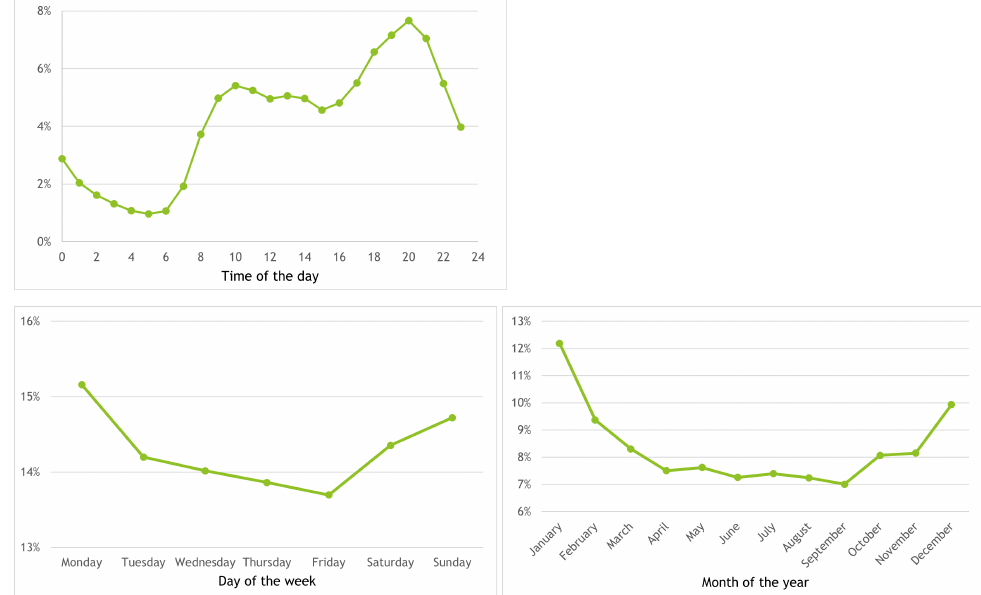
Figure 6. Distribution of calls per hour of the day (top ), day of the week ( bottom-left ) and month of the year ( bottom-right